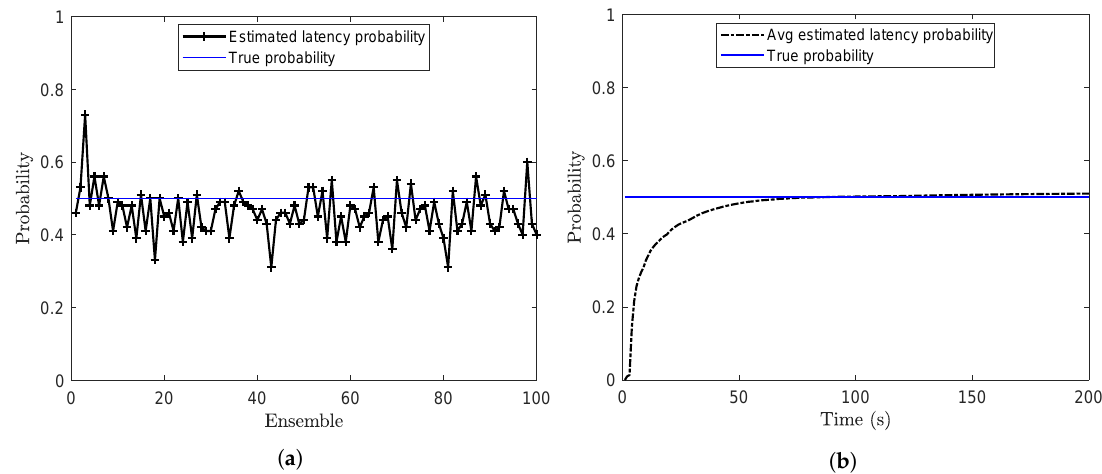
Figure 6. Estimated latency probability ( a ) Offline estimation ( b ) Online estimation (Problem 2).